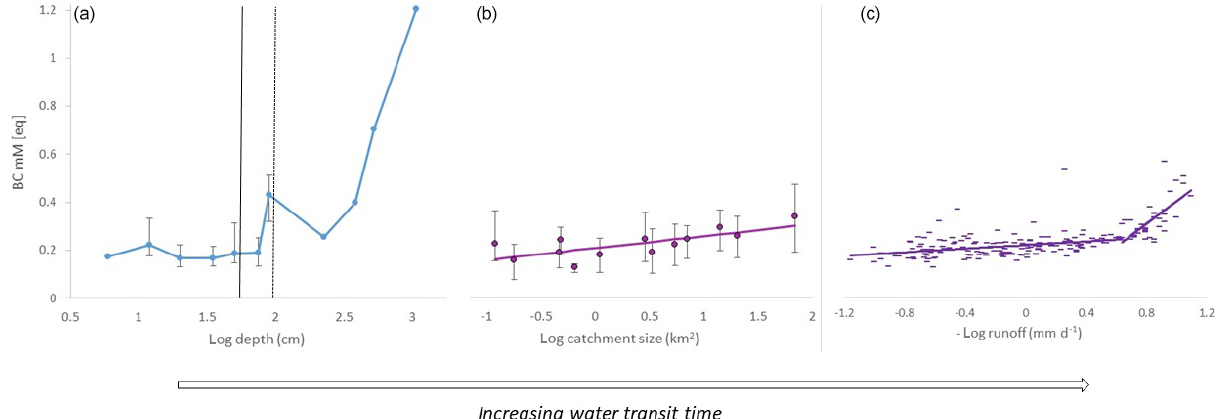
Figure 3. Base cation concentrations (mM eq) plotted against different proxies for water transit time. (a) Soil water concentrations in the S22 soil profile (22m from stream C2), sampled from a depth of 6 to 10.7m below the surface. Uncertainty bars represent the minimum and maximum concentration observed over 8 years of sampling ( N = 45–69). Vertical lines represent the approximate highest and lowest groundwater surface depth. (b) Stream water concentrations in samples from 2016 ( N = 19–25) from the Krycklan Basin plotted against the subcatchment size (range of 0.12–67km 2 ). Uncertainty bars represent the minimum and maximum concentration observed during sampling. (c) Stream water concentrations in samples from 2003 to 2012 from stream C2 (0.12km 2 ) plotted against the negative logarithm of runoff. Note that stream C2 displayed in panel (c) is the same as the smallest stream in panel (b) but for two different sampling periods.